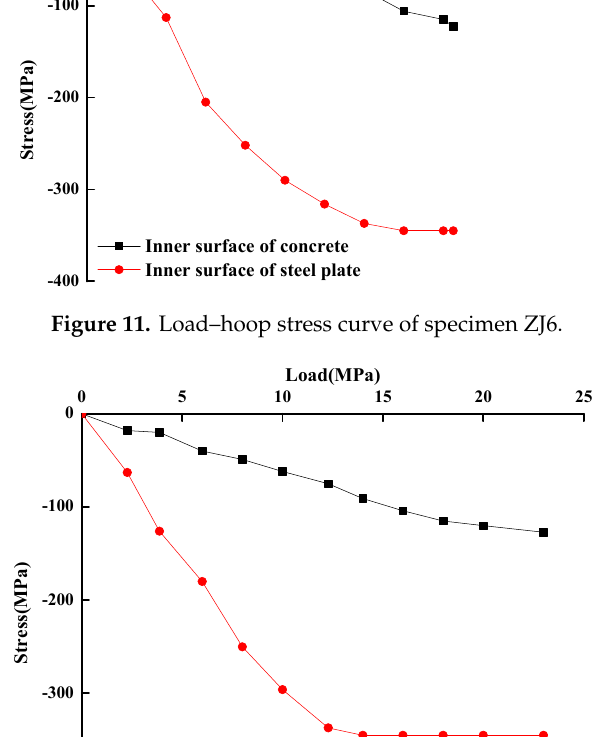
Figure 11. Load–hoop stress curve of specimen ZJ6. Figure 12. Load–hoop stress curve of specimen ZJ8. Figure 12. Load–hoop stress curve of specimen